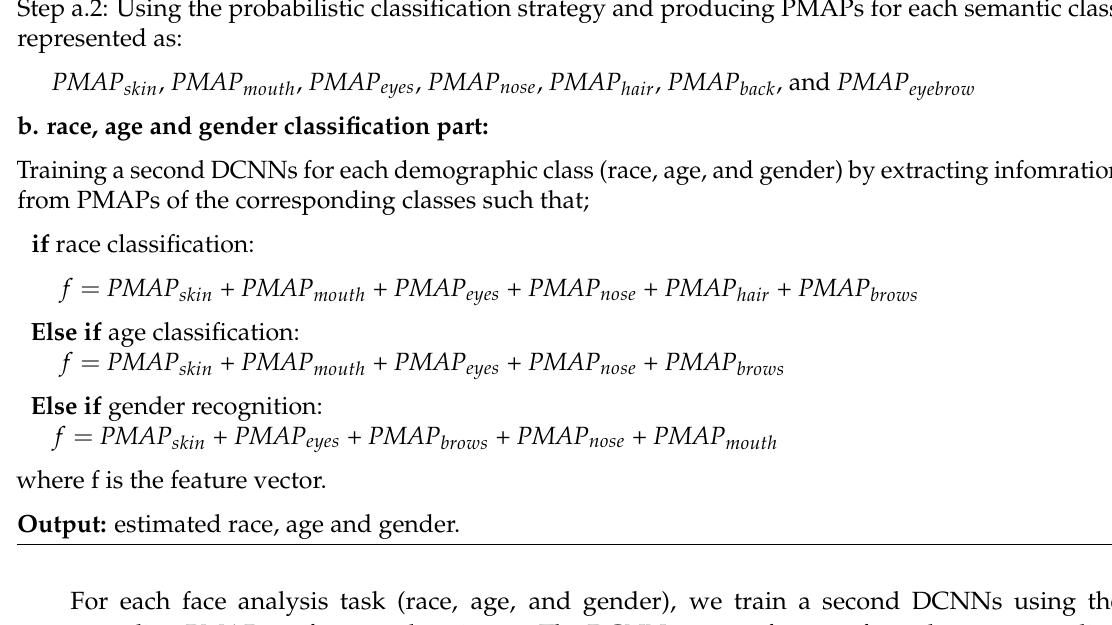
Algorithm 1 proposed RAG-MCFP-DCNNs